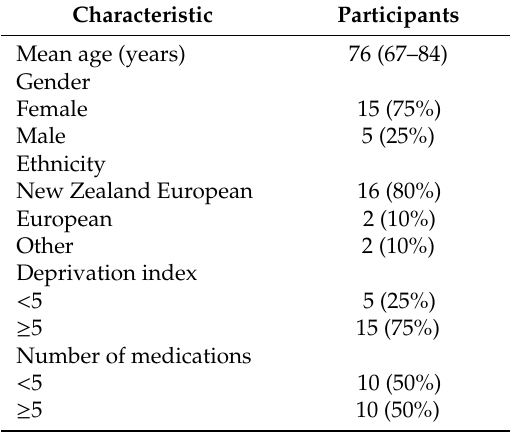
Figure 1. Flow diagram of participant recruitment. FODMAP: fermentable oligosaccharides, disaccharides, monosaccharides, and polyols. Table 1. Demographic characteristics of twenty study participants that were included in the pilot study.